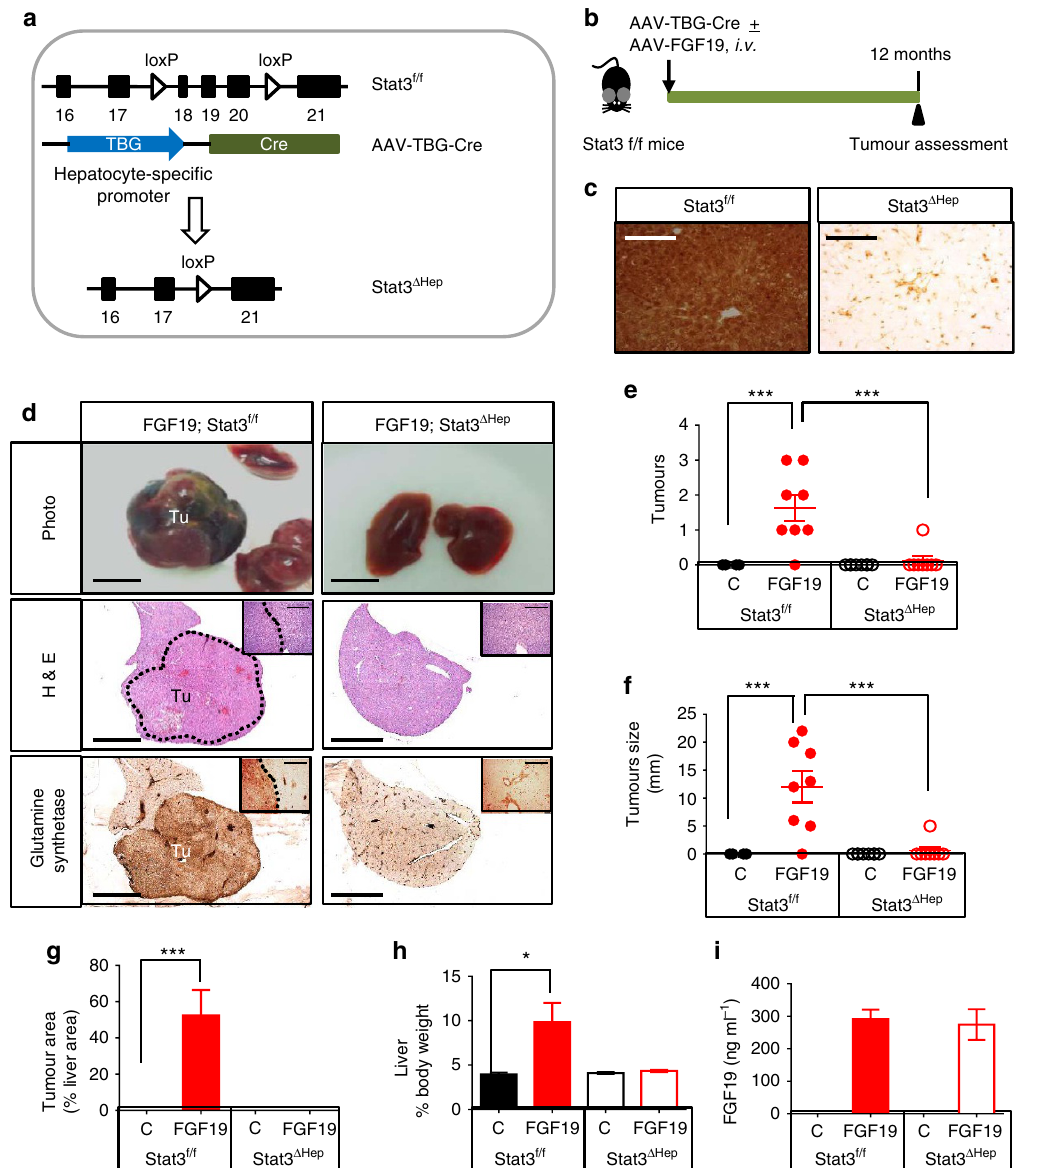
Figure 1 | Hepatocyte-specific ablation of STAT3 eliminates FGF19-associated tumorigencity. ( a ) Schematic representation of generating Stat3 D Hep mice with AAV-mediated delivery of Cre recombinase. The thyroxine binding globin (TBG) promoter drives hepatocyte-specific Cre expression. Exons in Stat3 gene are labelled. ( b ) Study design. 14 to 18 week-old Stat3 f/f mice received a single tail vein injection of AAV- FGF19 ( n ¼ 8), or a combination of AAV- FGF19 and AAV-TBG-Cre ( n ¼ 8), or a control virus GFP (C) ( n ¼ 5). Mice were killed 12 months after AAV administration for liver tumor analysis. ( c ) Confirmation of hepatocellular STAT3 ablation by immunohistochemical staining with anti-STAT3 followed by DAB substrates (brown colour). Abundant STAT3 proteins were detected in livers from Stat3 f/f mice, but not Stat3 D Hep mice. Note residual STAT3 expression in non-parenchymal cell in Stat3 D Hep mice. Scale bars, 100 m m. ( d ) FGF19 induces HCC in Stat3 f/f mice ( n ¼ 8), but not Stat3 D Hep mice ( n ¼ 8). Shown are representative macroscopic view, and liver sections stained with H&E or anti-glutamine synthetase. DAB substrates (brown colour) were used for immunohistochemistry. Tu, tumours. Scale bars, 5mm. Higher magnifications of liver sections are shown in insets. ( e ) Liver tumour multiplicity. Dots in scatterplot represent individual animals. ( f ) Liver tumour size recorded as maximum tumour diameter in each mouse. ( g ) Quantification of glutamine synthetase-positive tumour area as a percentage of total liver area. ( h ) Liver weights from mice of the indicated genotypes. ( i ) Circulating levels of FGF19 at the end of the study. Values are mean ± s.e.m. *** P o 0.001, * P o 0.05 by unpaired, two-tailed t -test of indicated